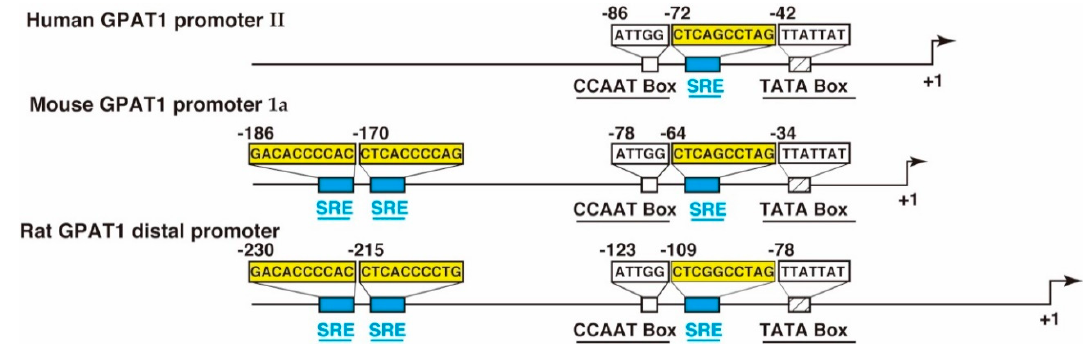
Figure 4. A schematic representation of the human acyl-CoA:glycerol- sn -3-phosphate acyltransferase1 (GPAT1) promoter II [39], the mouse GPAT1 promoter 1a [36], and the rat GPAT1 distal promoter [37]. The location of the sterol regulatory element (SRE) motif, the inverted CCAAT box, and the TATA box are shown. The number indicates the position from the transcription start site, which is designated as +1.